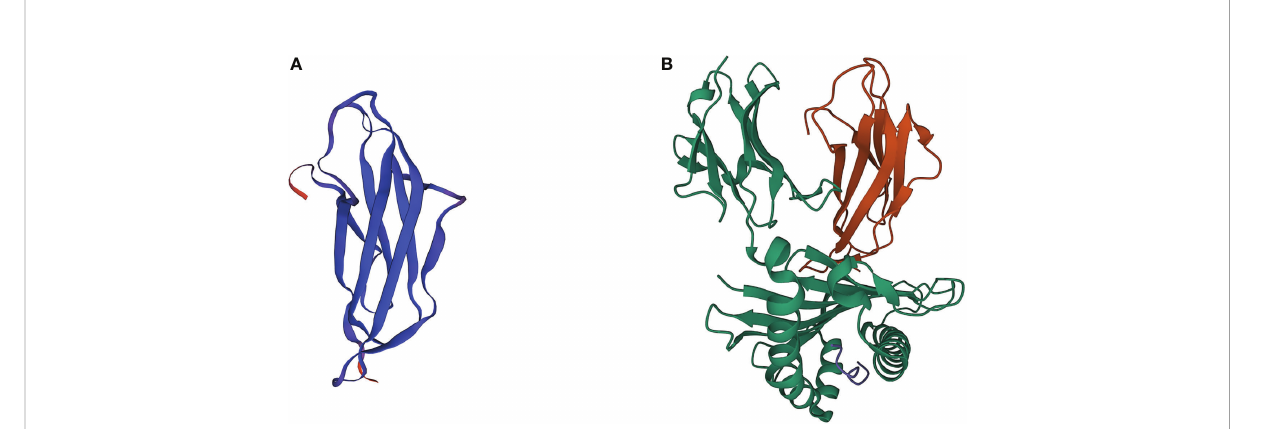
FIGURE 1 3D crystal structures of b 2M and MHC class I complex. (A) 3D crystal structures of human b 2M. (B) 3D crystal structures of b 2M and HLA-B complex (PDB: 3BP4). Orange ribbons indicate b 2M, while green ribbons indicate the HLA